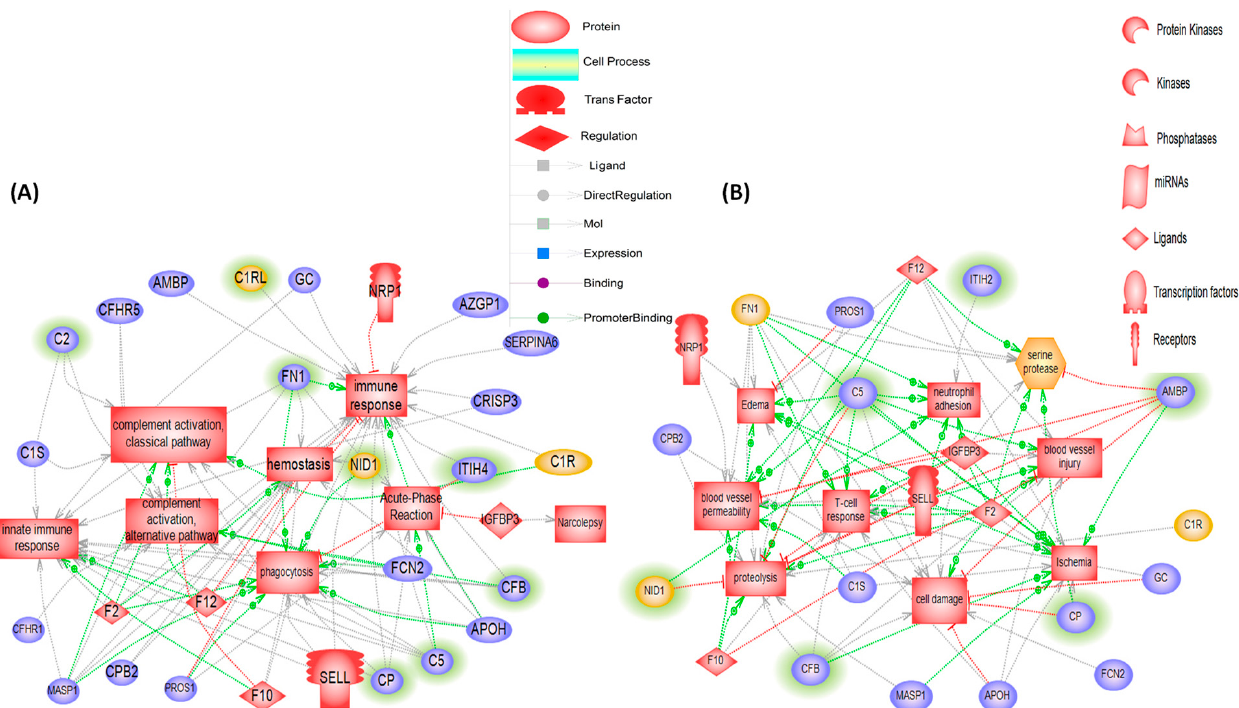
Figure 4. The global interactome of DEPs in NT1. ( A ) Altered pathways and network of DEPs involved, ( B ) Altered cellular processes and network of DEPs associated. The DEPs hollowed in green are validated by LC-PRM-MS.